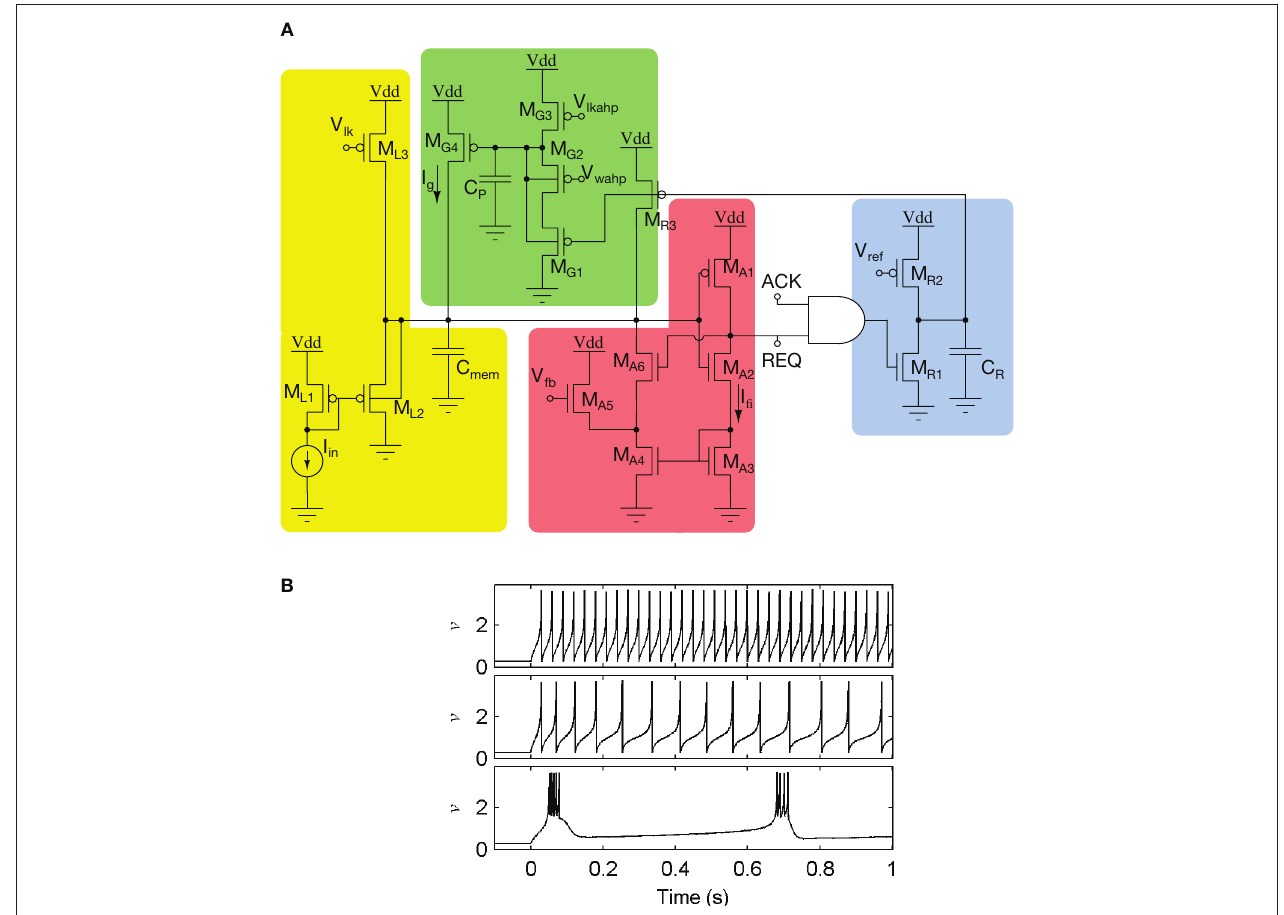
FIgure 13 | The log-domain LpF neuron (LLN). (a) The LLN circuit comprises a membrane LPF (yellow, M element (red, M ), a reset-refractory pulse generator (blue, M A1 − 6 LLN fabricated in 0.25 μm CMOS, exhibits regular spiking, spike-frequency adaptation, and bursting (top to